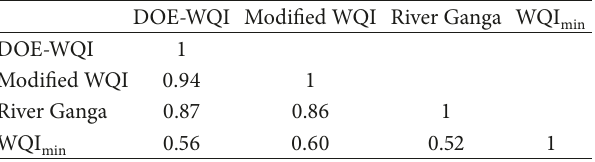
Table 6: Correlation coefficients ( 𝑅 values) between the four indexing